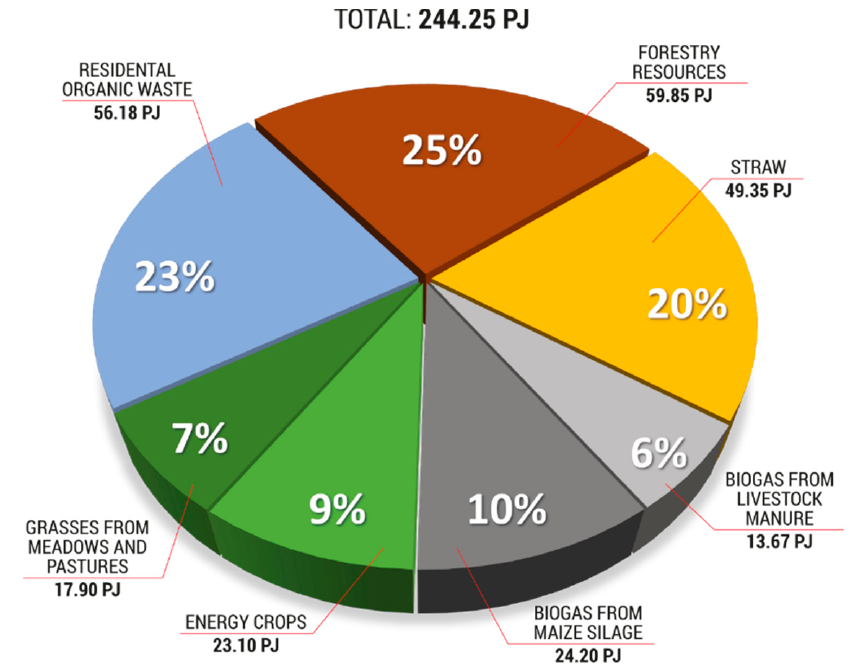
Figure 4. Potential for energy production from agricultural and residential resources in Poland.